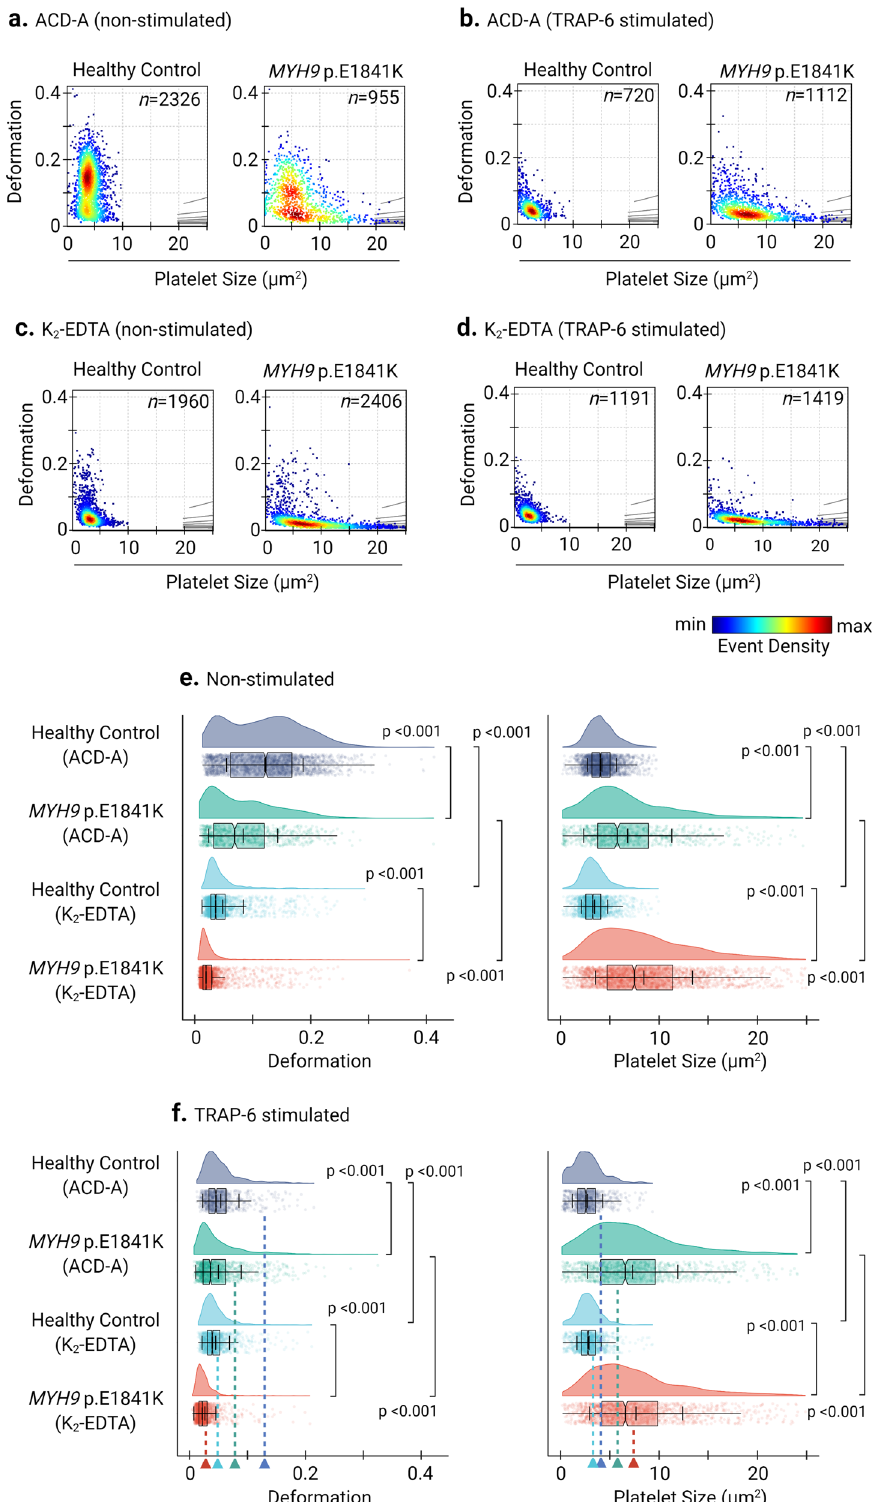
Fig. 7 Deformability and size of platelets from a healthy individual and from a patient carrying MYH9 p.E1841K mutation. KDE scatter plots from RT-FDC measurements performed on the same day of displaying the distribution of single platelet deformability and their corresponding size between single platelets from a healthy individual (control) and from a patient carrying the mutation MYH9 p.E1841K for non-muscle myosin heavy chain IIa, in ex vivo anticoagulant ( a ) ACD-A and ( c ) in K 2 -EDTA before and after stimulation with platelet agonist TRAP-6, ( b ) and ( d ), respectively ( n = number of single platelets). Statistical distribution plots for platelet deformation and size for ( e ) non-stimulated and ( f ) TRAP-6 stimulated platelets from each experimental condition from fi gure panels ( a ) through ( d ). Notch in the box plot and the horizontal line depicts median and mean, respectively, and the interquartile ranges. The full distribution of the data for each parameter is depicted by half-violin plots and staggered dots and dotted lines with arrowheads represent the median values of respective parameters from the non-stimulated platelets. Statistical assessment by Kruskal – Wallis test followed by Dunn ’ s multiple comparisons test. p < 0.05 was considered signi fi